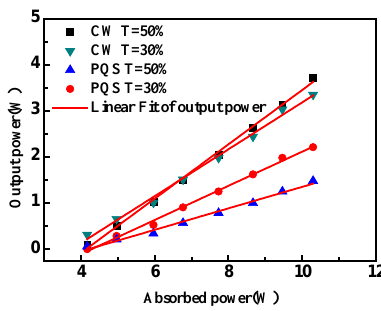
Figure 2. Variation of average output power versus absorbed pump power.